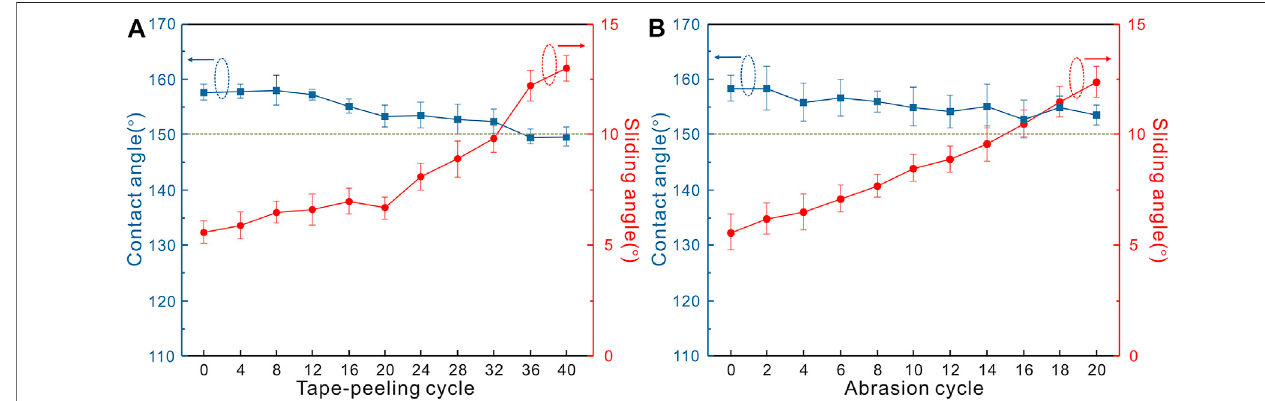
FIGURE9| Variations ofwatercontactanglesandslidingangles ofthesuperhydrophobicAl 2 O 3 @PDMS coatingafterdifferent (A) tapepeelingand (B) sandpaper abrasion cycles.